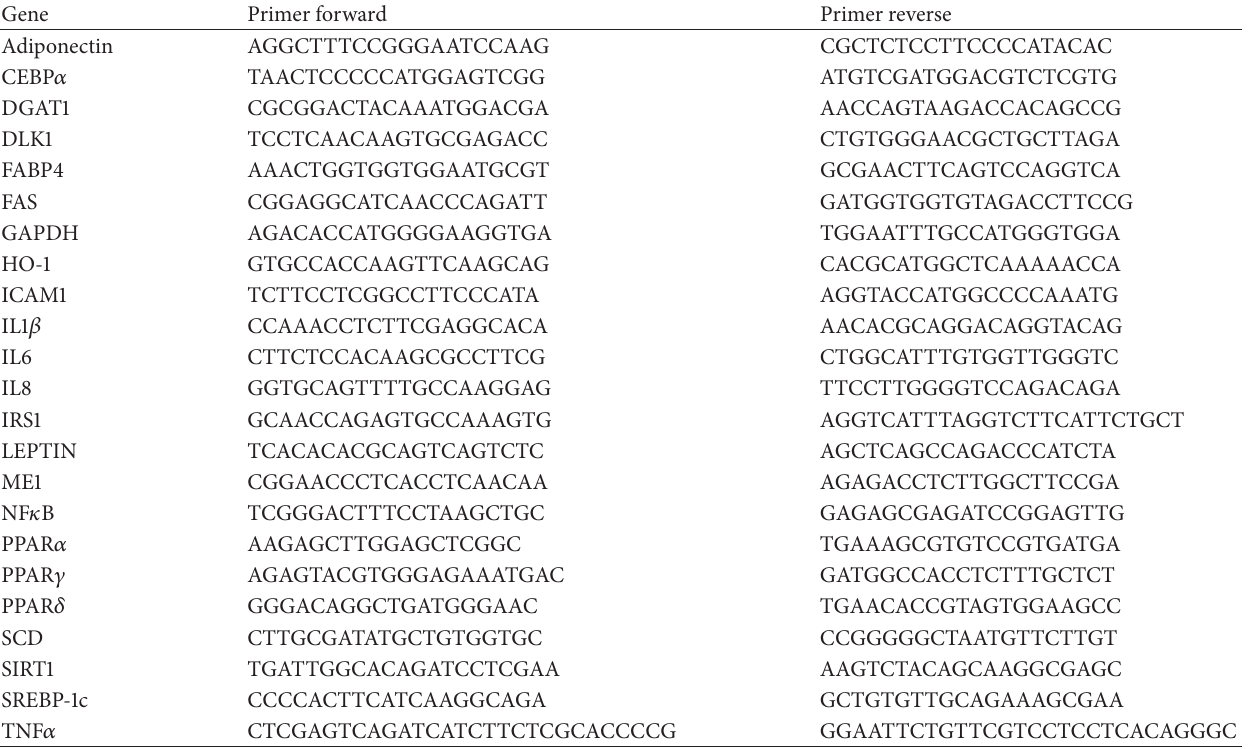
Table 1: PCR primers used in this